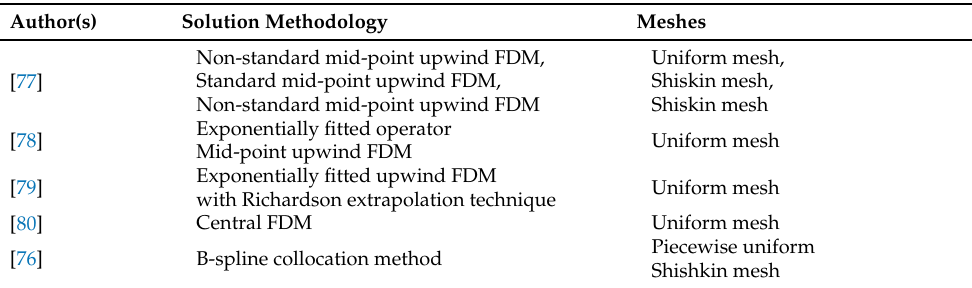
Table 9. Various methods and mesh used to solve Equations (13) and